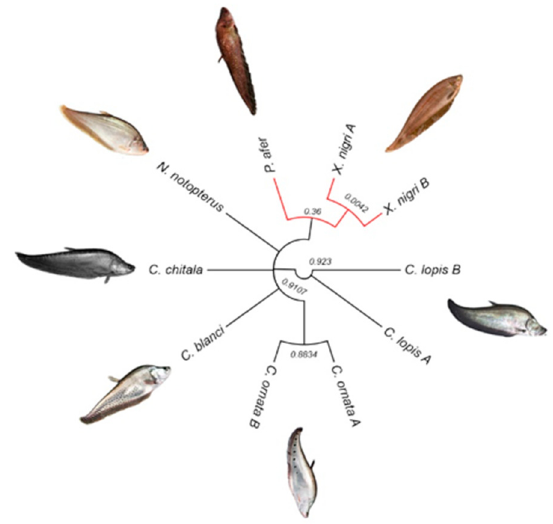
Figure 10. Dendogram generated by Bayesian combined molecular and chromosomal data from the notopterid family. Red branches represent species from Africa. Numbers in the nodes represents the Bayesian posterior probabilities.